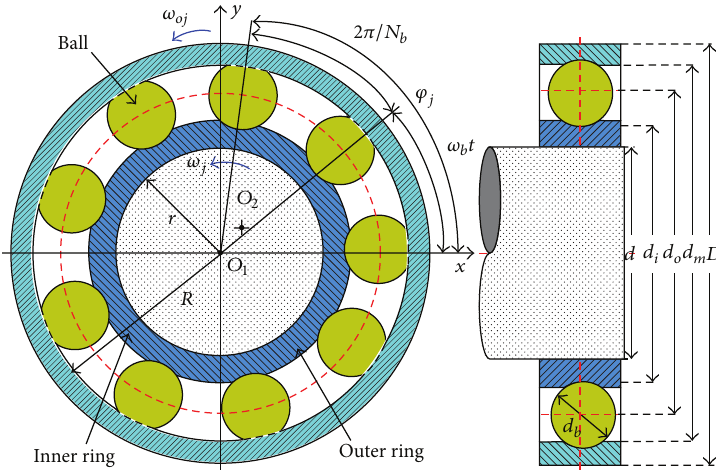
Figure 3: Rolling bearing model.